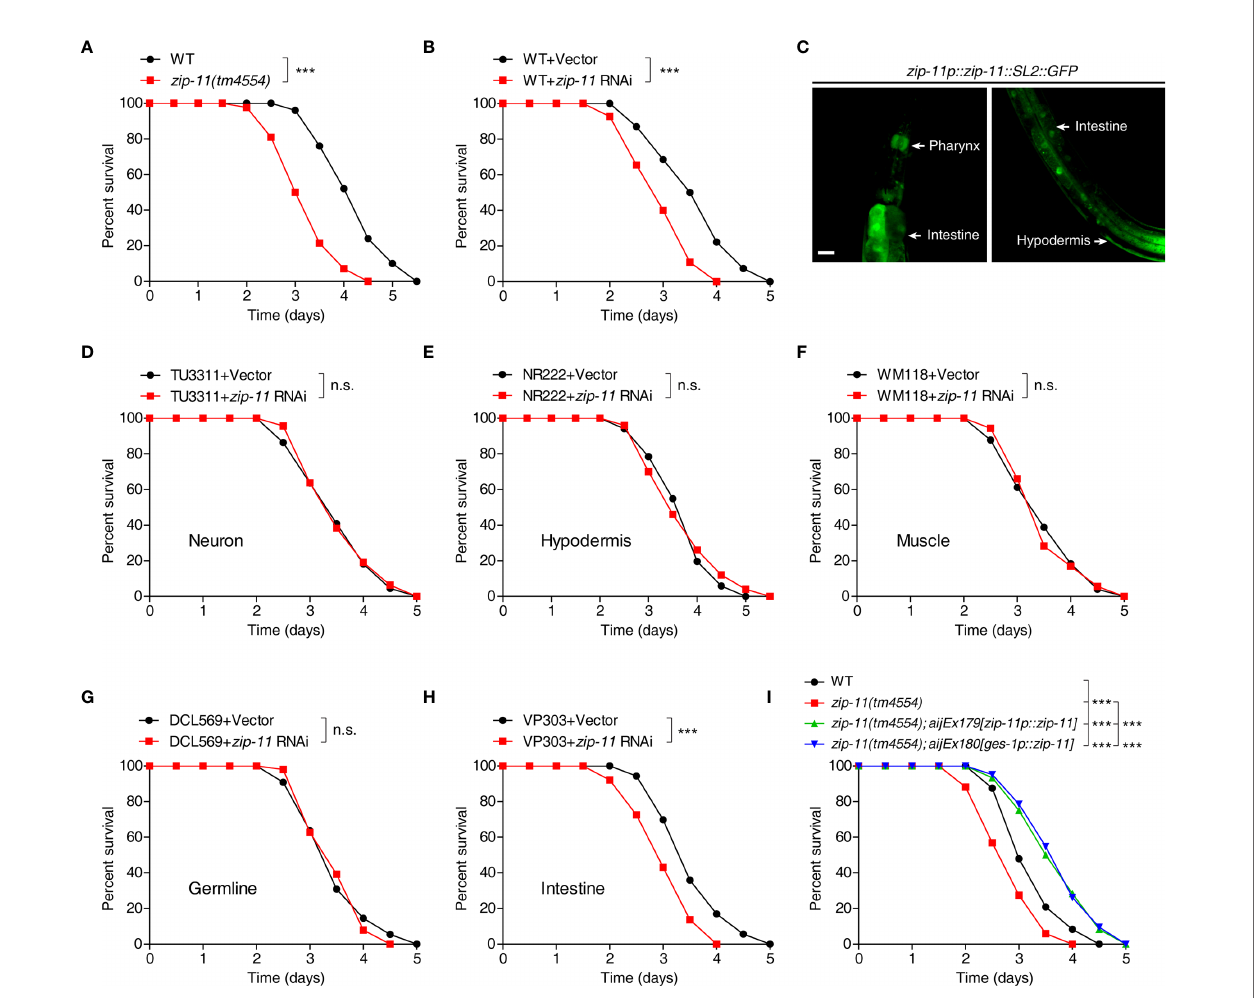
FIGURE 2 | Intestinal ZIP-11 activates innate immunity against P. aeruginosa PA14 infection. (A) WT worms and zip-11(tm4554) worms were exposed to P. aeruginosa PA14 and scored for survival. (B) WT worms fed with vector control or zip-11 RNAi bacteria were exposed to P. aeruginosa PA14 and scored for survival. (C) High magni fi cation images of zip-11p::zip-11::SL2::GFP transgenic worms show zip-11 is expressed in intestine, pharynx, and hypodermis. Scale bar: 20 m m. (D – H) Tissue-speci fi c RNAi worm strains including TU3311/neuron (D) , NR222/hypodermis (E) , WM118/muscle (F) , DCL569/germline (G) and VP303/ intestine (H) fed with vector control or zip-11 RNAi bacteria were exposed to P. aeruginosa PA14 and scored for survival. (I) WT, zip-11(tm4554) , zip-11(tm4554); aijEx179[zip-11p::zip-11] and zip-11(tm4554);aijEx180[ges-1p::zip-11] worms were exposed to P. aeruginosa PA14 and scored for survival. Statistical signi fi cance was determined by log-rank test for killing assays. Please see Table S4 in Supplementary Material for detailed statistical analysis of killing assay data. ***p < 0.001; n.s., not signi fi